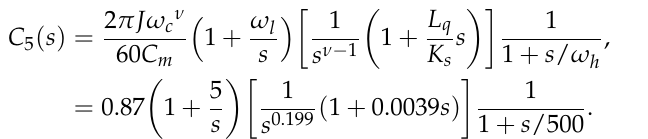
Table 5. Step response performance indices of the systems